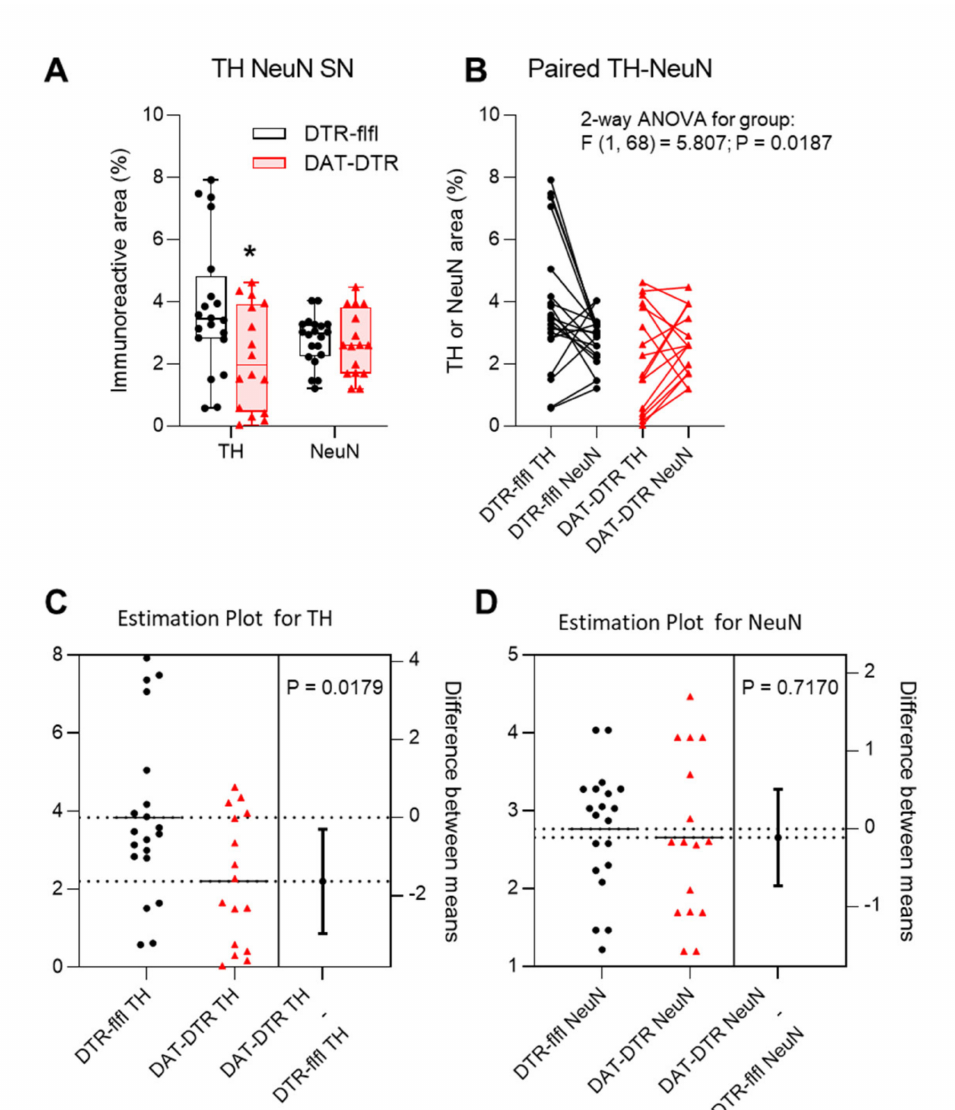
Figure 3. Quantification and statistical comparison of TH and NeuN immunofluorescence. ( A , B ) Box/scatter plot and Paired data analysis of the TH and NeuN immunopositive areas de- termined with the Particle Counter in FIJI ImageJ. The scatter represents images of the left and right SN of 4–6 mice per group. Data of TH and NeuN were compared by ANOVA and subsequent unpaired, two-tailed t-test for TH and NeuN separately. The asterisk shows a significant result with p < 0.05. ( C , D) Estimation plots for TH and NeuN showing the group difference obtained via